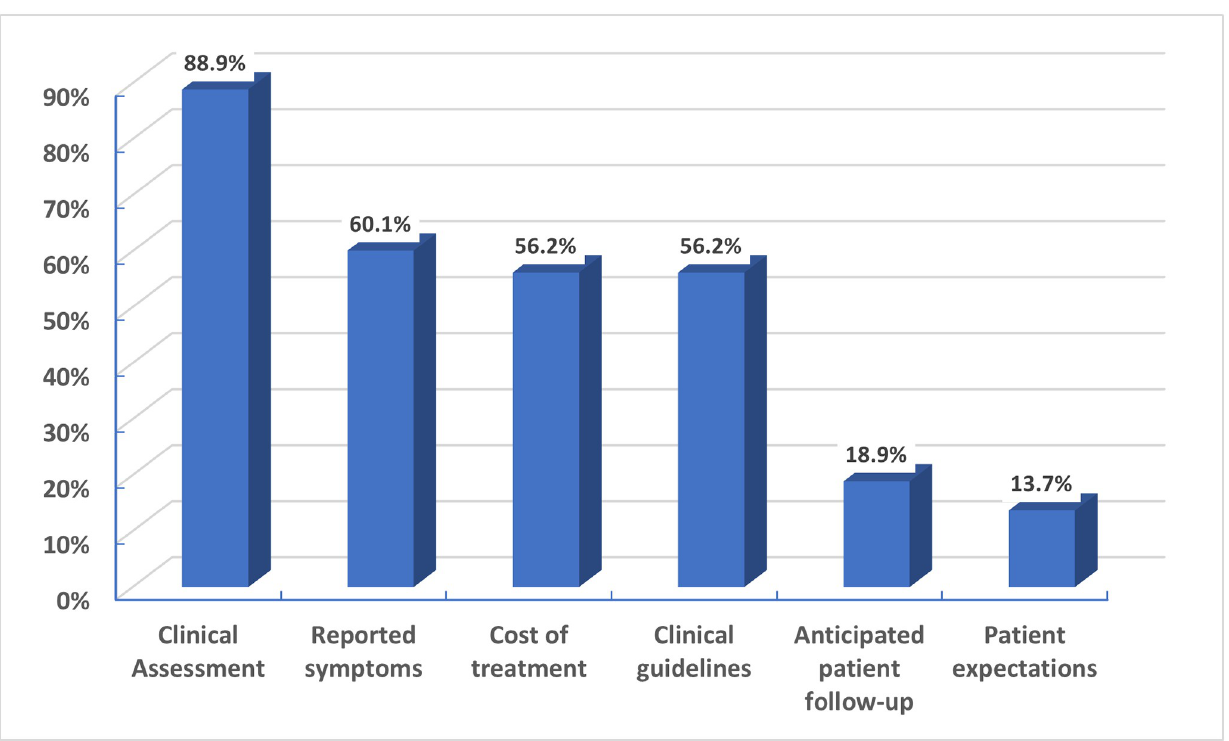
Fig 2. Factors affecting antibiotic prescribing as reported by